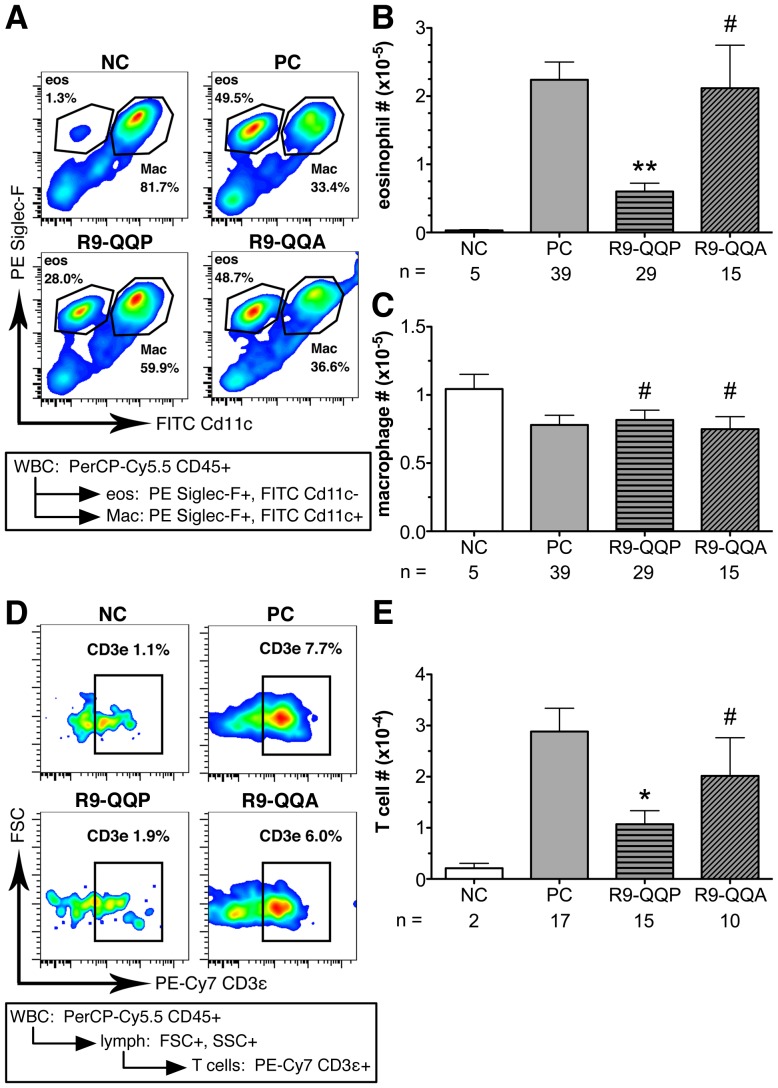
R9-QQP specifically inhibits eosinophilia.(A) Representative flow cytometric density plots obtained by specific antibody staining of BAL fluid cells from mice treated as indicated in Figure 2A and detailed in Materials and Methods. Inset box at bottom of graph outlines staining and analysis strategy: CD45+ cells gated and analyzed for Siglec-F and CD11c expression as described in Materials and Methods. Gates depict eosinophils and macrophages as percentages of total CD45+ cells. (B,C) Average (± SEM) number of eosinophils and macrophages respectively, calculated as described in Materials and Methods for the indicated number (n) of mice that had been treated as in panel (A). (D) Separate aliquots of BAL fluid cells from the experiment depicted in panel (A) analyzed as indicated in the inset box at the bottom of the graph: CD45+ cells gated by scatter and analyzed for CD3ε+ cells as described in Materials and Methods. Gates depict T lymphocytes as percentage of total CD45+ cells. (E) Average (± SEM) number of T cells calculated as described in Materials and Methods for the indicated number (n) of mice that had been treated as in panel (D). Axes in all histograms are displayed on a log scale for all fluorescence channels and on a linear scale for FSC. **, p < 0.0001; #, p>0.05; *, p<0.005.